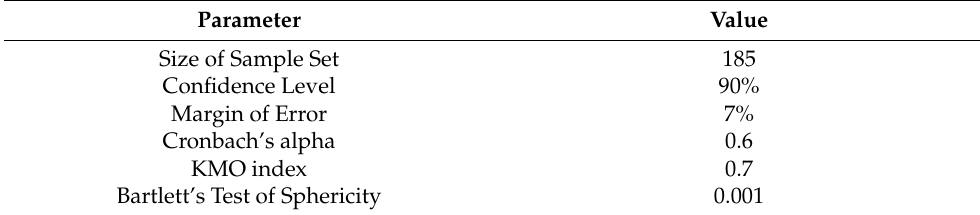
Table 1. Summary of the statistical parameters of this